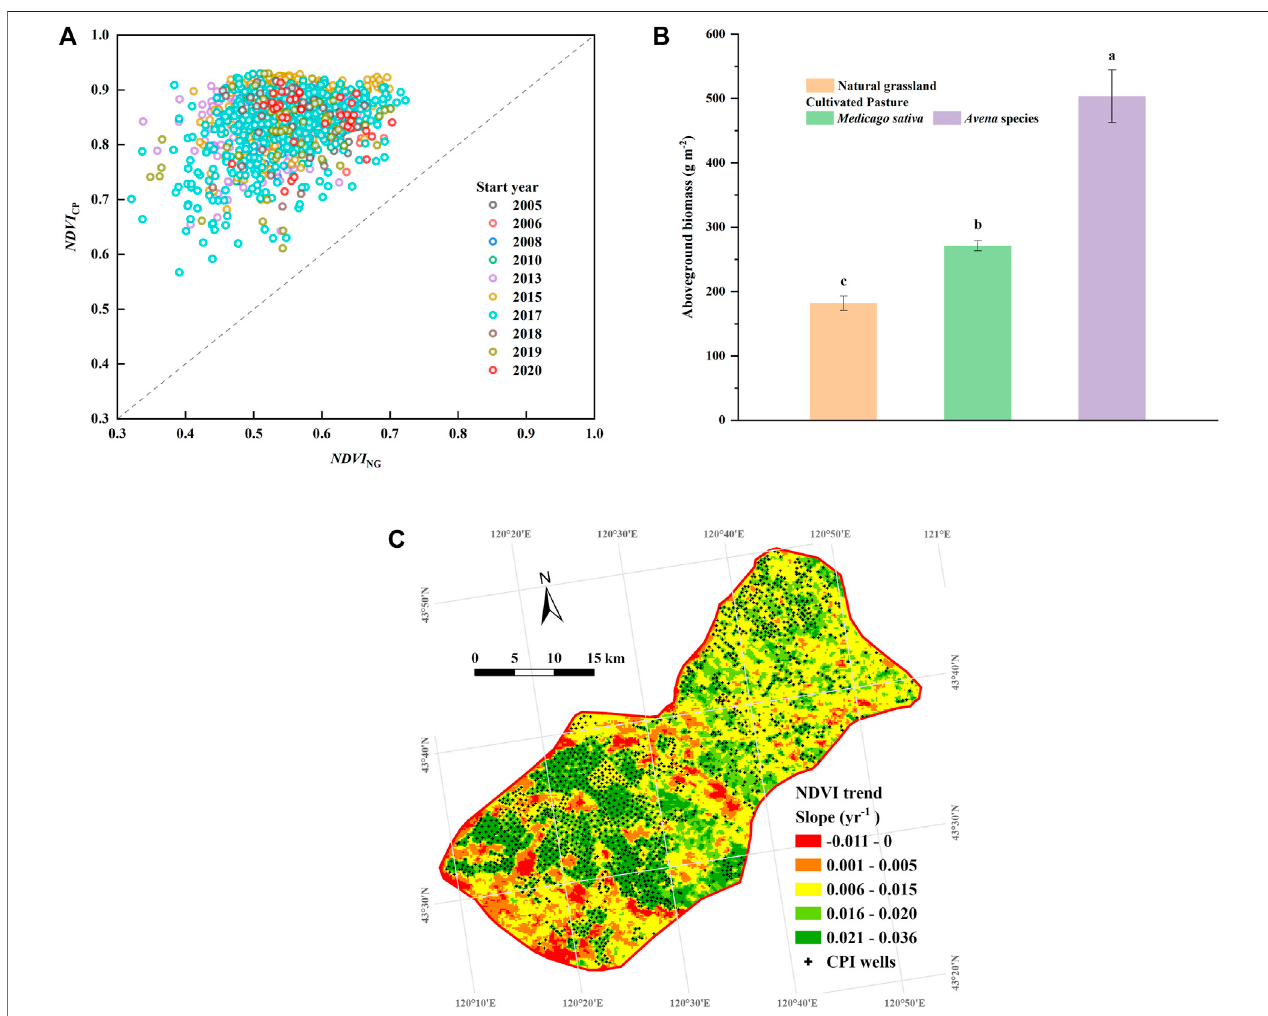
FIGURE 5 | Comparison of the normalized difference vegetation index ( NDVI ) and aboveground biomass between natural grassland (NG) and cultivated pasture (CP). (A) Relationshipbetween NDVI NG and NDVI CP dividedbythestartyearofirrigation( NDVI NG ,valuesbeforethestartyear,naturalgrassland; NDVI CP ,valuesfromthe startyear,cultivatedpasture,e.g.,2010representsthemeanfrom2010to2021). (B) Differencesinabovegroundbiomassbetweennaturalgrasslandandthecultivated pastures. (C) Trend of NDVI ( NDVI slope ) from 2000 to 2021 related to the locations of the center-pivot irrigation (CPI) wells.